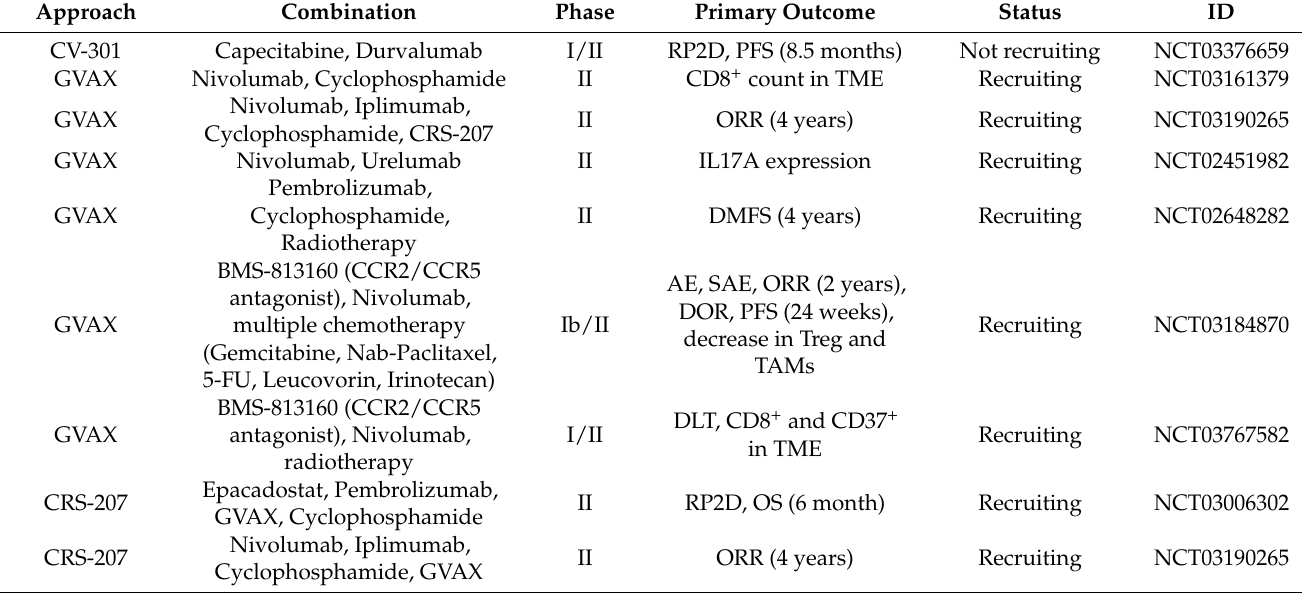
Table 10. Clinical trials testing cancer vaccines and CAR-T based therapies for pancreatic cancer.